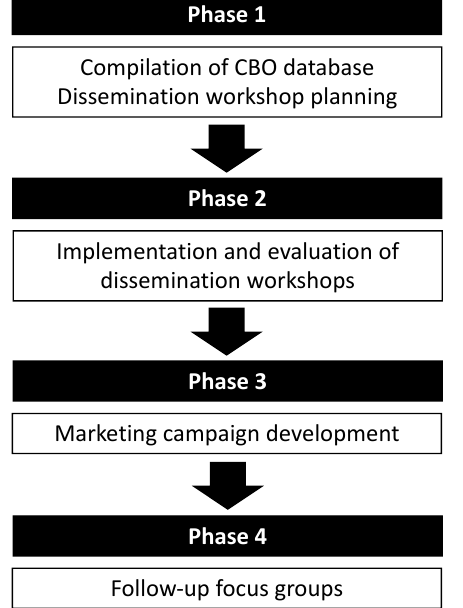
Figure 2. SA 24-h movement guidelines dissemination project phases. CBO, community-based organisations.